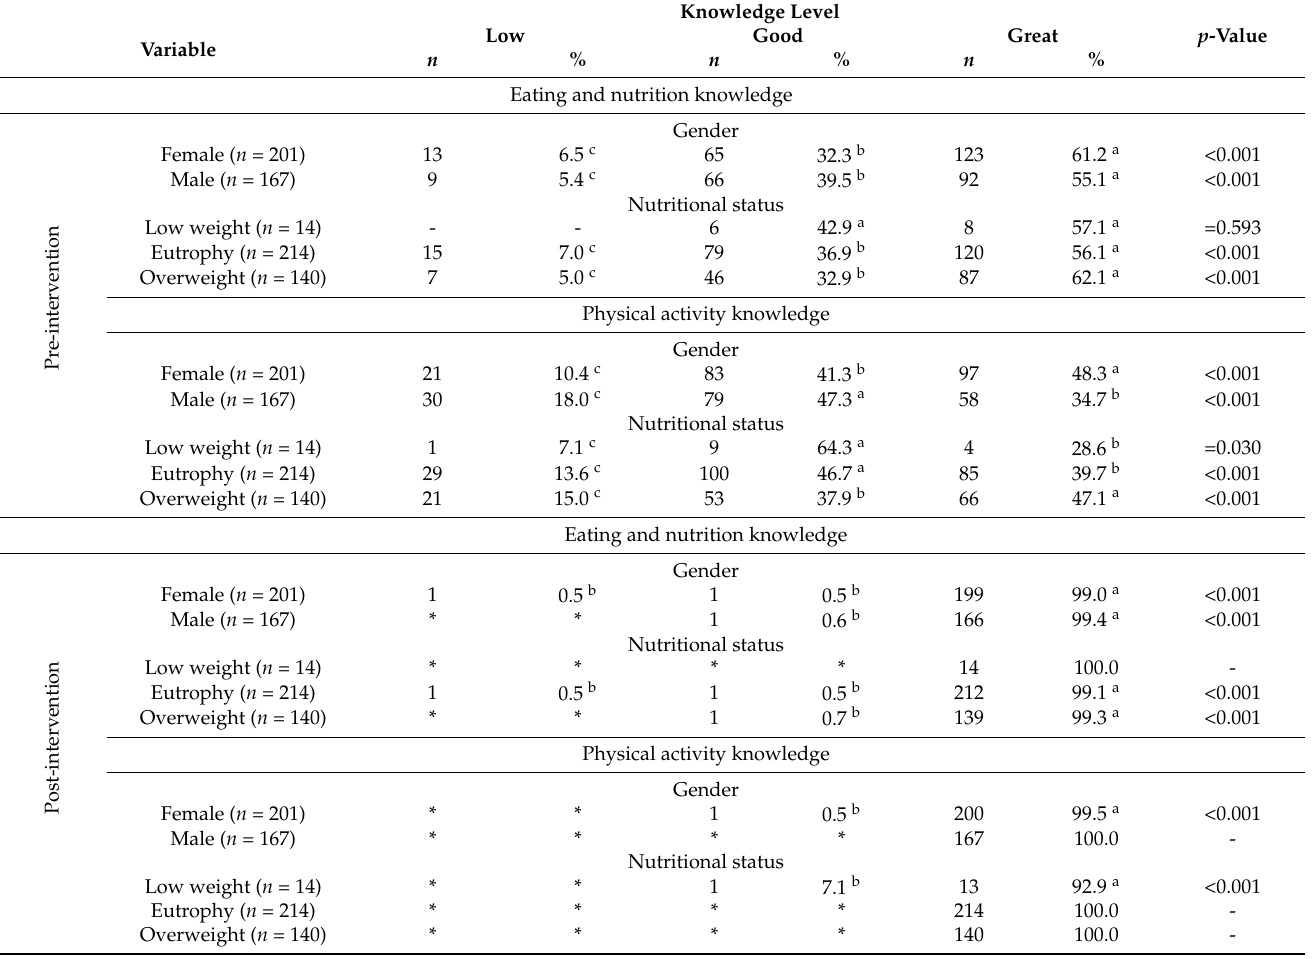
Table 3. Children’s knowledge level regarding eating, nutrition, and physical activity in the pre- and post-intervention stages, considering gender and nutritional